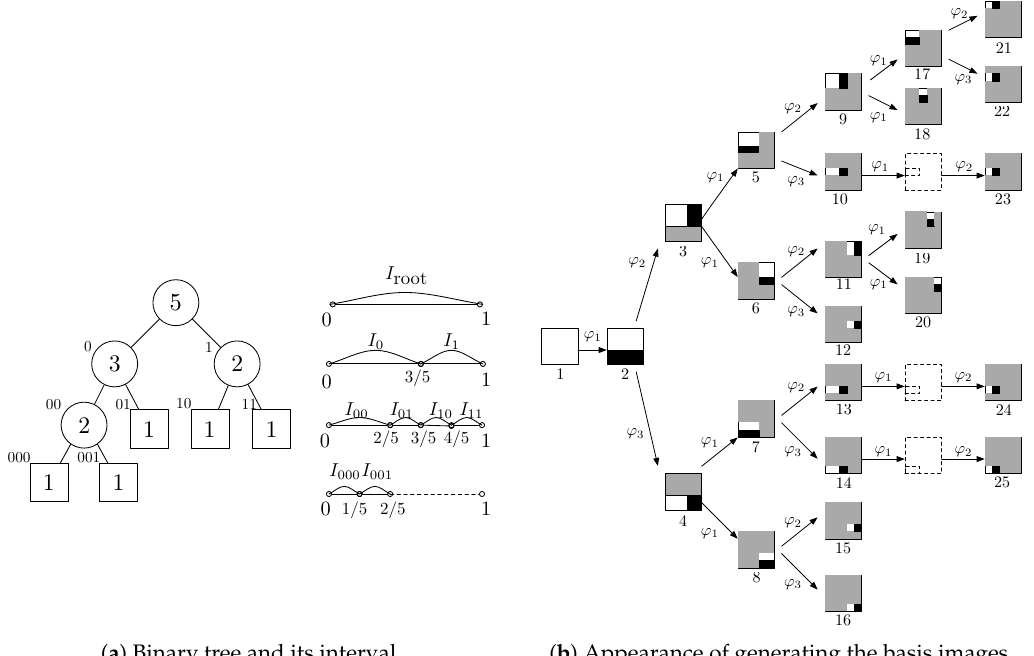
Figure 4. An example of OTSHT basis images based on a balanced binary tree having five